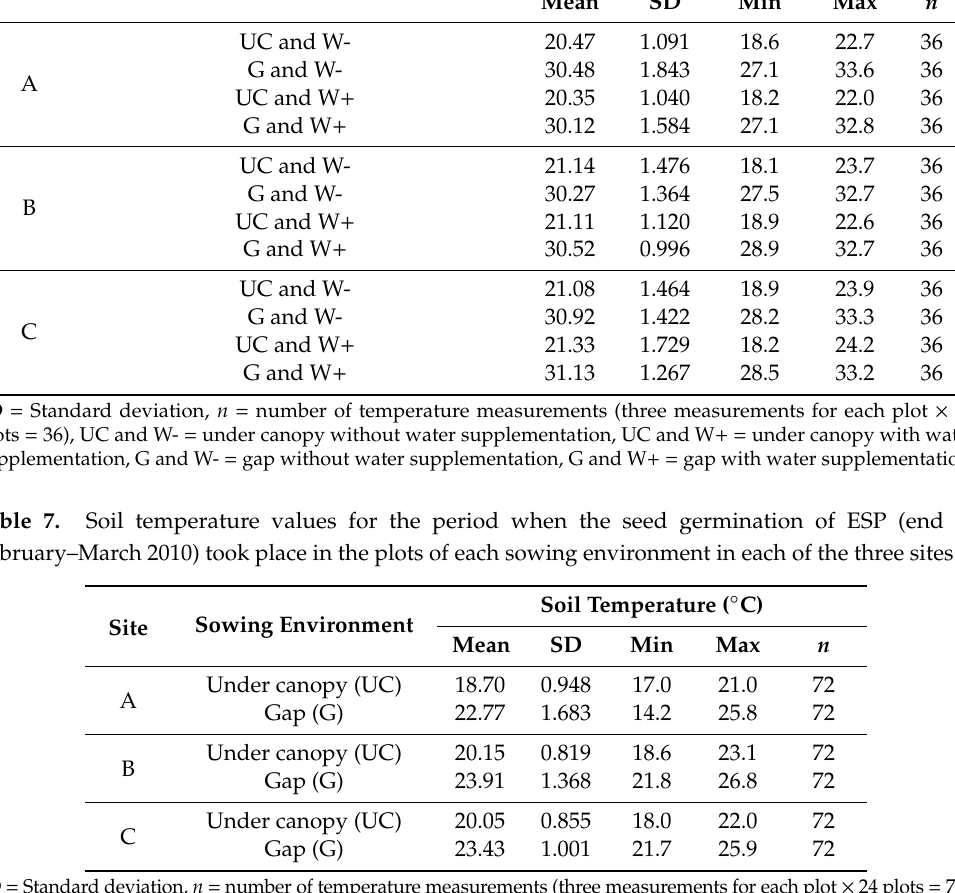
Table 6. Soil temperature values for the period when the seed germination of LSP (April–middle of May 2009) took place in the plots of each combination of the two factor levels in each of the three sites. Site Combinations of the Two Factor Levels